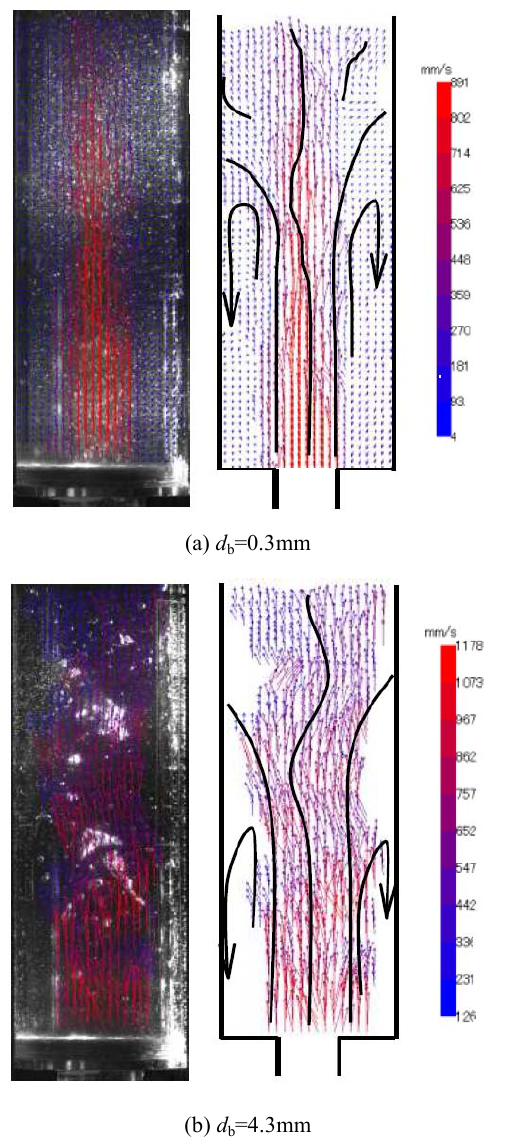
Fig.3 PIV analysis results for, α (Instantaneous flow